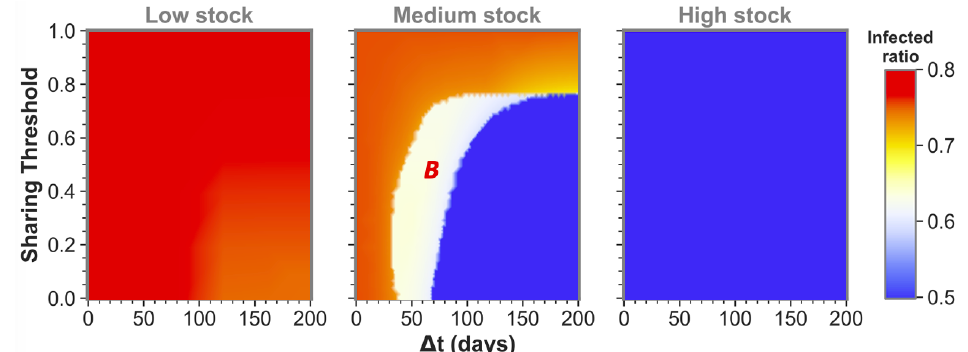
Figure 2. Influence of epidemic onset time difference and sharing threshold on total infected ratio for equal maximum stock communities. The epidemic is introduced in A at t = 0, and in B at t = ∆ t . The indicated infected ratio is the average of the two communities’ infected ratios. The red state indicates both communities reaching a high infected ratio and white means that one community (labeled with the red letter, here B ) had a high infected ratio while the other remained low. In the blue state both communities had a relatively low amount of infected. For each phase plot, the two communities had the same maximum stock, being either S max = 1 × 10 7 (Low stock), S max = 3 × 10 7 (Medium stock) or S max = 7 × 10 7 (High stock). n = 1.7 × 10 7 , R 0 = 2.3, γ = 1/6, r = 0.4, w = 4,